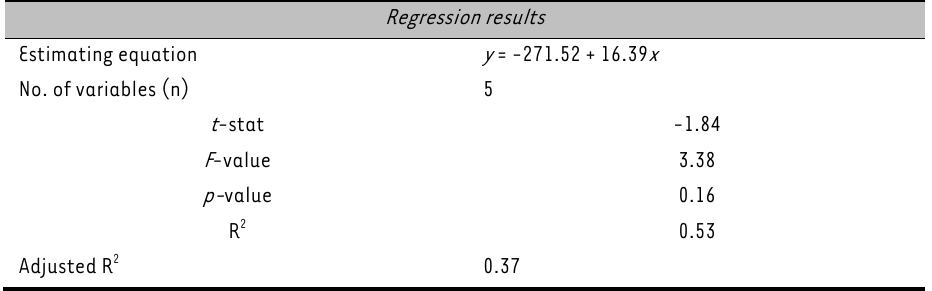
Regression results